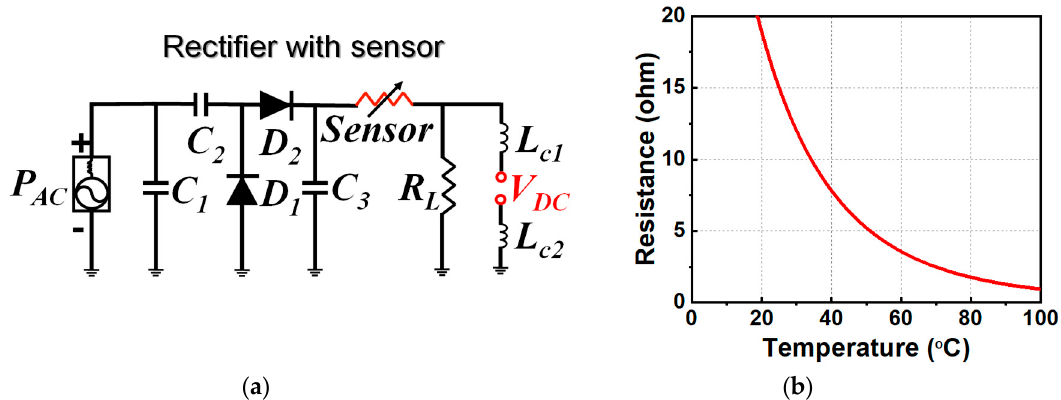
Figure 4. Sensor-augmented rectifier: ( a ) circuit model and ( b ) thermistor resistance as a function of the temperature.